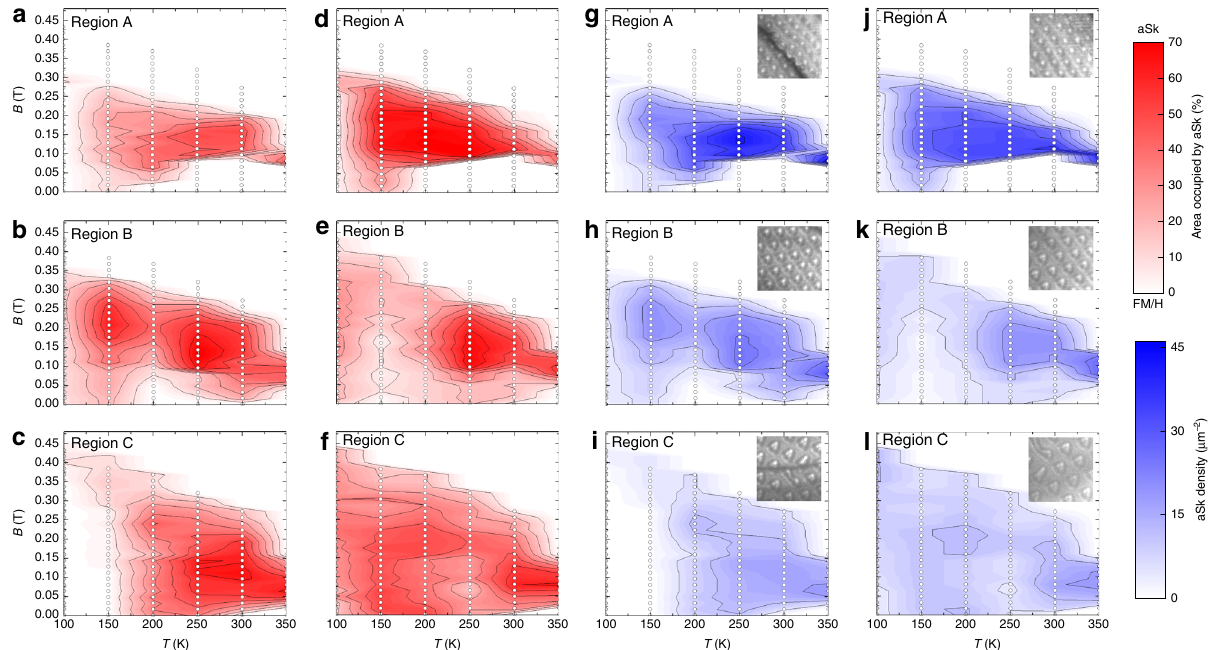
Fig. 4 Magnetic phase diagram of the wedge-shaped lamella. The experiments are performed after zero- fi eld-cooling (ZFC) and fi eld-cooling (FC), as a function of temperature ( T ) and perpendicular magnetic fi eld ( B ), for three distinct regions A, B, and C. The area occupied by the aSk phase is shown in ( a – c ) for ZFC and in ( d – f ) for FC. The aSk density is shown in ( g – i ) for ZFC and in ( j – l ) for FC. The insets (1 × 1 μ m 2 ) in ( g – l ) show LTEM images of the aSk lattice recorded in 0.176 T at 250 K. Note that 70% corresponds to a pure aSk lattice (for details see SI). The white dots in each phase diagram indicate the magnetic fi eld and temperature where LTEM images were